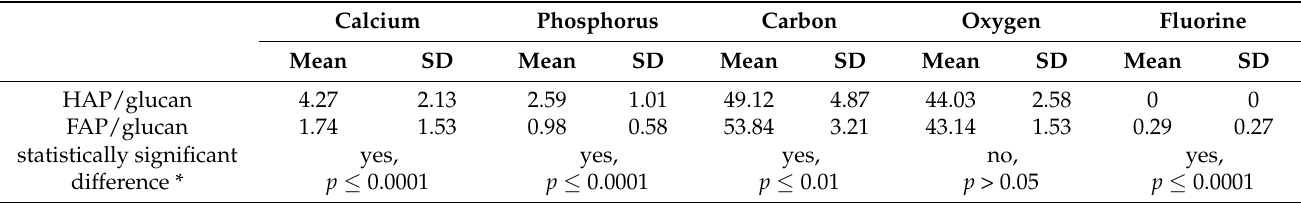
Table 2. Mean element content (expressed as atomic percent) on polymeric surface of materials according to EDS